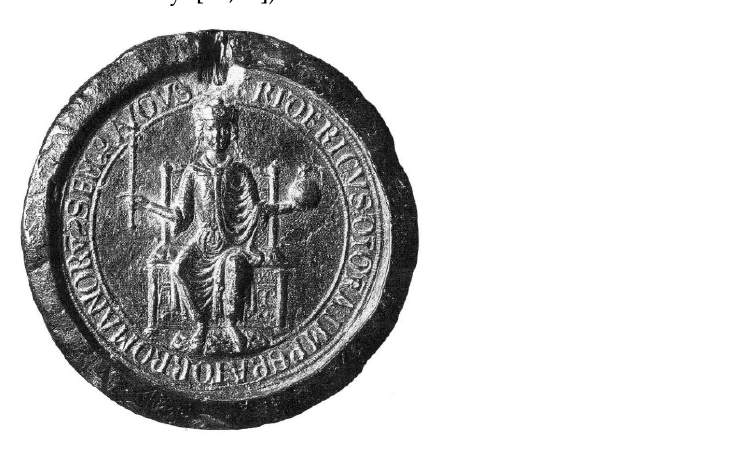
Figure 1. Seal of Frederick II of Hohenstaufen as emperor, impression on red wax, February 1224. München, Bayerische Hauptstaatsarchiv, diploma KS. 664. Image published in [12] (Figure 18).